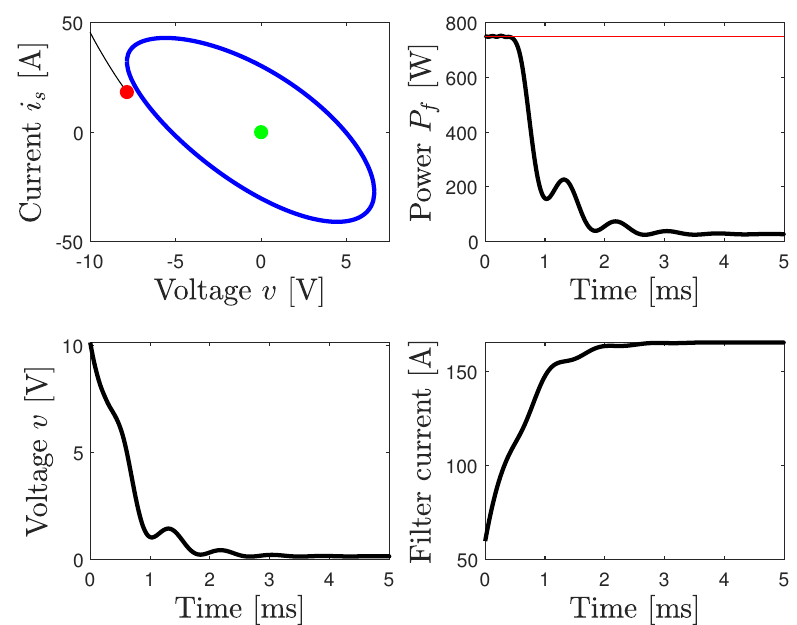
Figure 13. Unstable behaviour for initial condition outside invariant region S (750